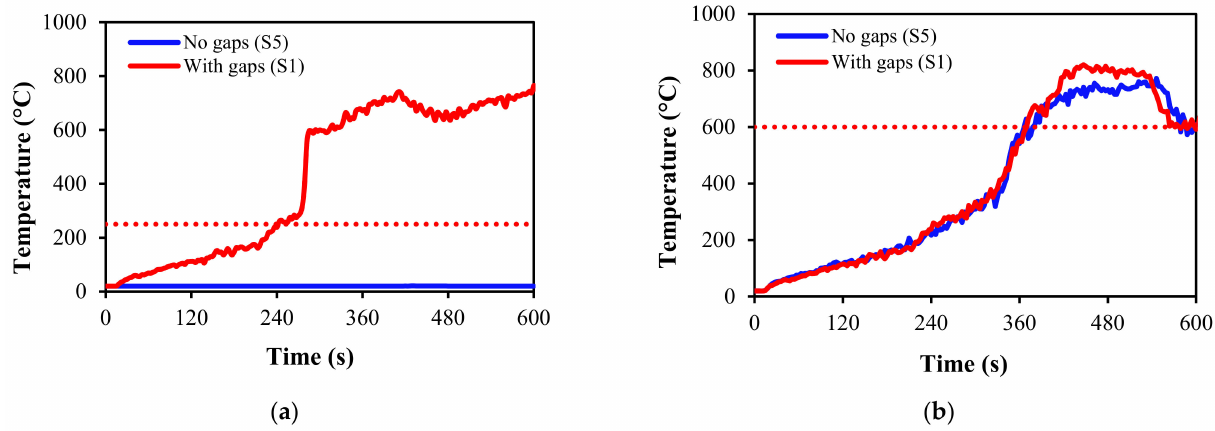
Figure 13. Effect of joining gaps of the panels on ( a ) internal temperature and ( b ) external temperature.